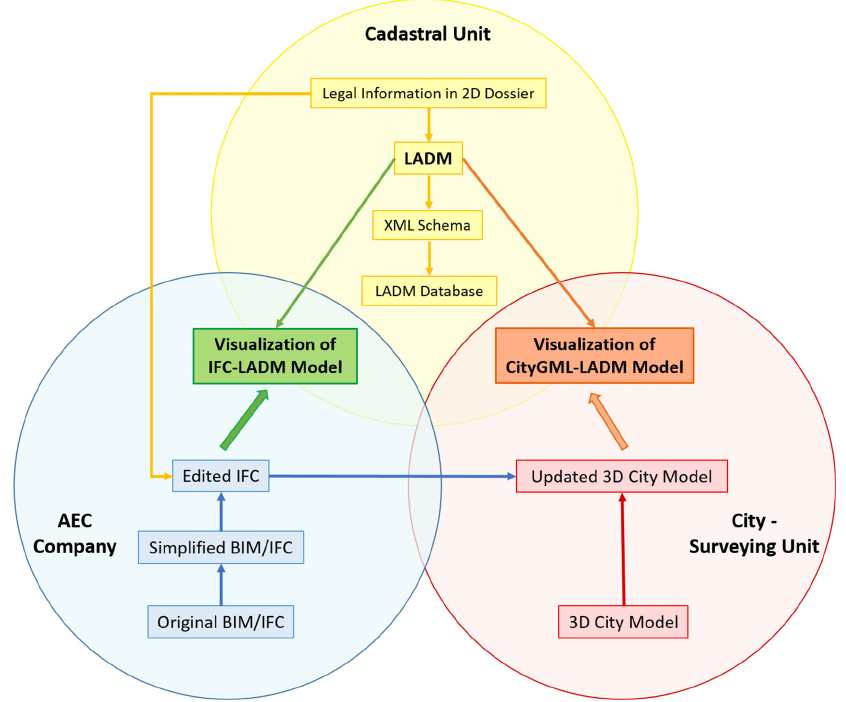
Figure 3. The general framework for integrating cadastre with building information model (BIM) and geographic information system (GIS). geographic information system